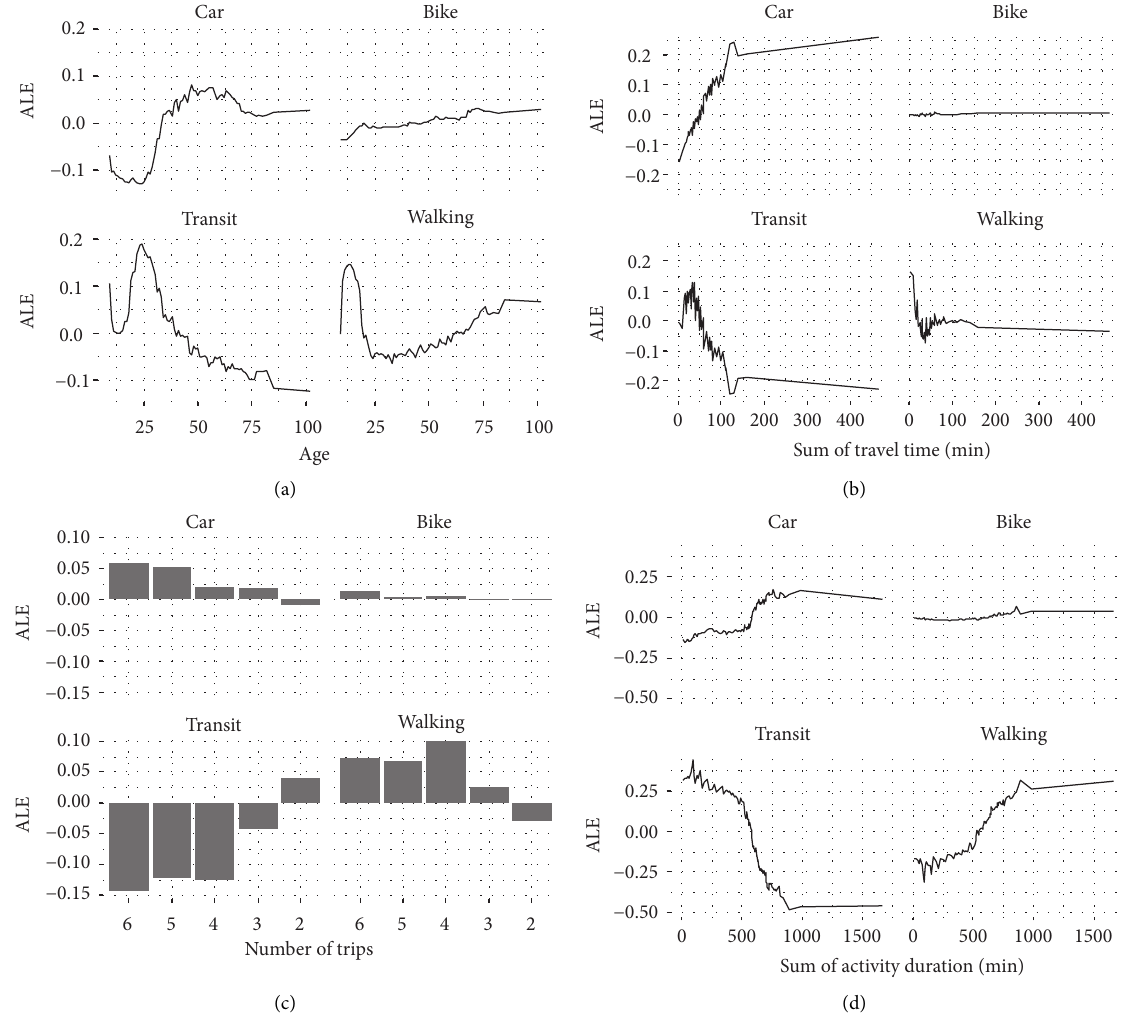
Figure 3: The ALE values of variables for predicting each travel mode: (a) car, (b) bike, (c) transit, and (d)